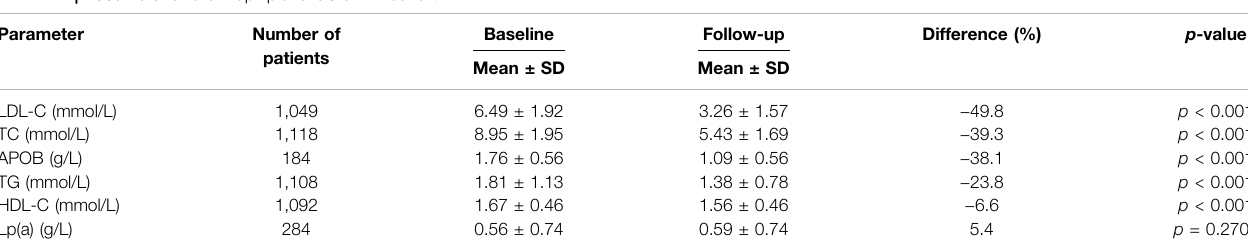
TABLE 2 | Baseline and follow-up lipid levels of FH